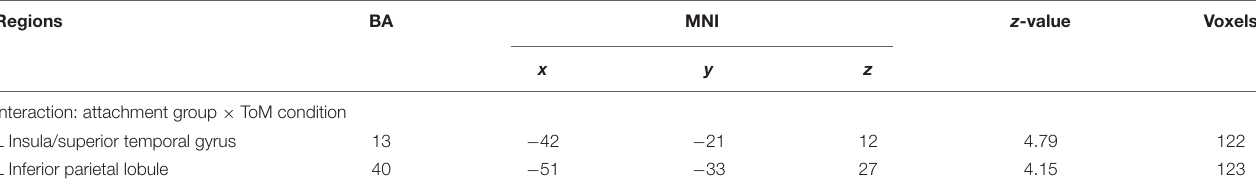
TABLE 5 | Regions for interaction between attachment group and preference condition at p < 0.001 (cluster > 90, Alphasim 0.001